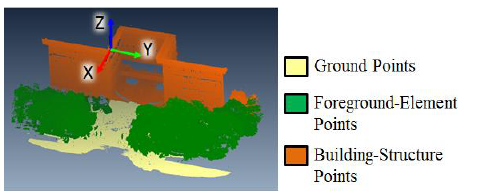
Figure 1. The classification of Lidar point clouds classification